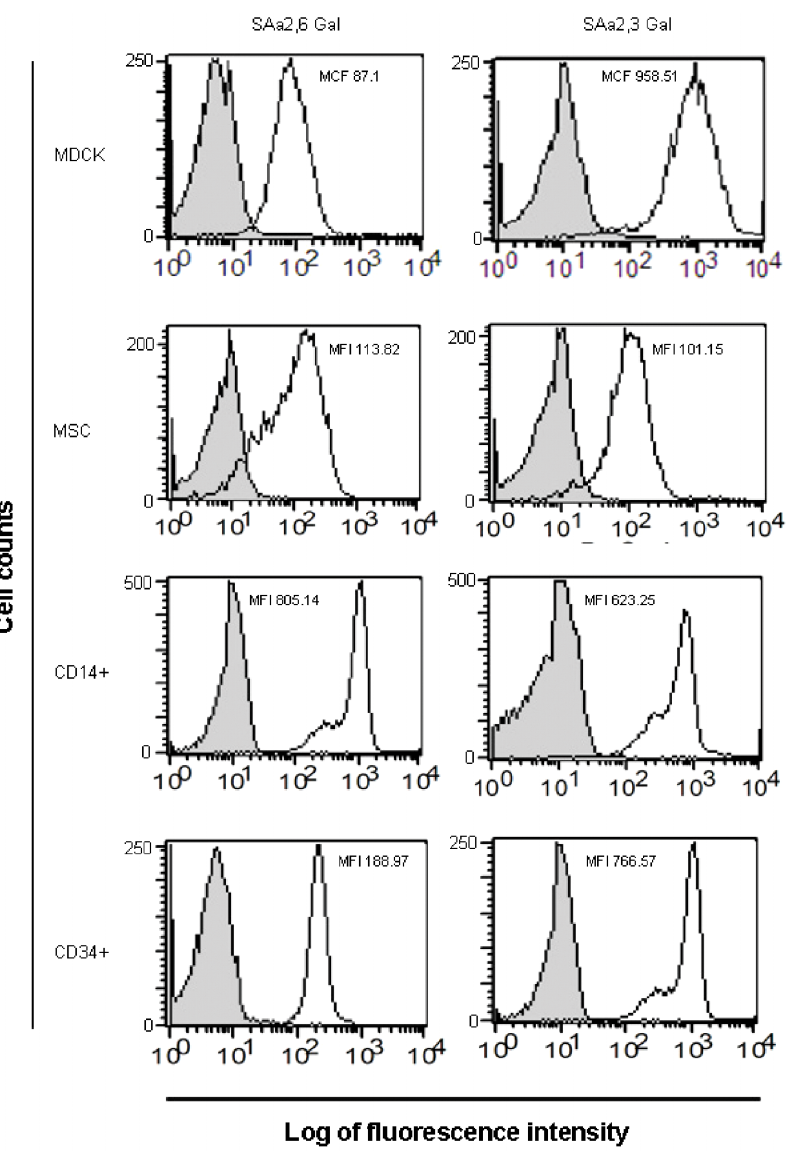
Figure 1. Relative amounts of Sialic Acid (SA) on the surface of various cell types. CD34 + HSCs, MSCs, CD14 + monocytes and MDCK cells were incubated with SNA and MAA which are specific for a 2,3 and a 2,6 SA, respectively, and determined by flow cytometry. The profile shown depicts cell number as a function of log fluorescence intensity of SA a 2,3Gal and SA a 2,6Gal specific lectin-reactive oligosaccharide on the cell surface. Relative mean fluorescent intensity (MFI) and mean channel fluorescence (MCF) which describe the brightness of fluorescein parameter were calculated by deducting MFI and MCF of negative control (Grey). Data are representative of three separate experiments.